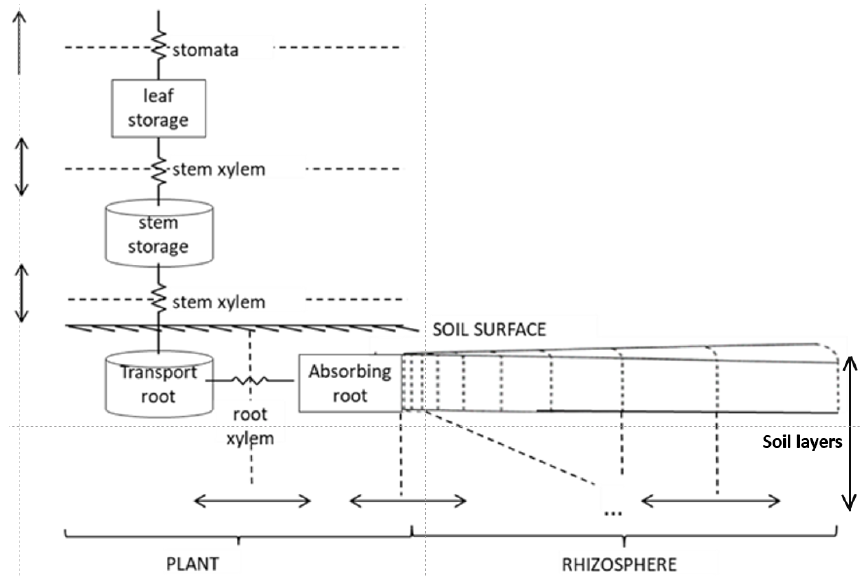
Figure 1. Structure of the FATES-Hydro model (Xu et al.,